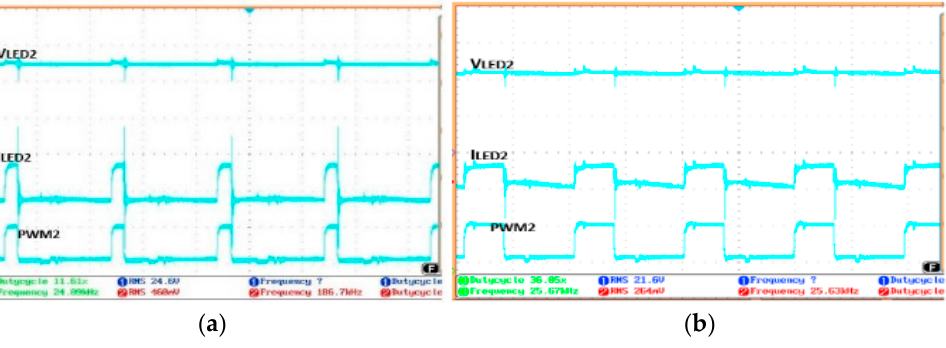
Figure 13. LED voltage and current with duty cycles (D 2 ) of ( a ) 11.61% and ( b ) 36.65% in LED string 2. Table 3. Current, voltage, and luminosity data variation with dimming. No. of